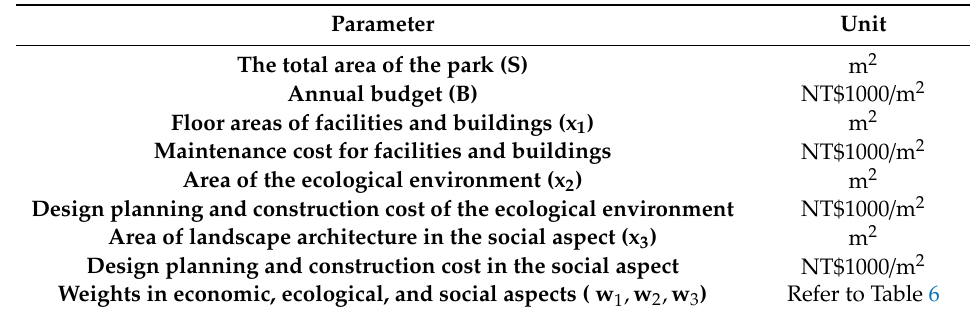
Table 7. Indicator importance rankings.